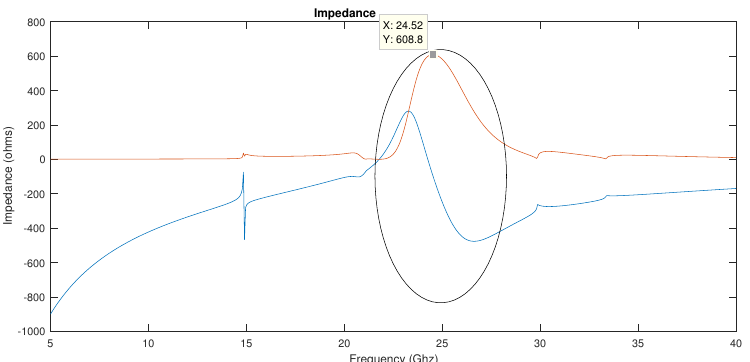
Figure 3. Impedance variation against frequency band around 24 GHz: obtained by the MoM- GEC